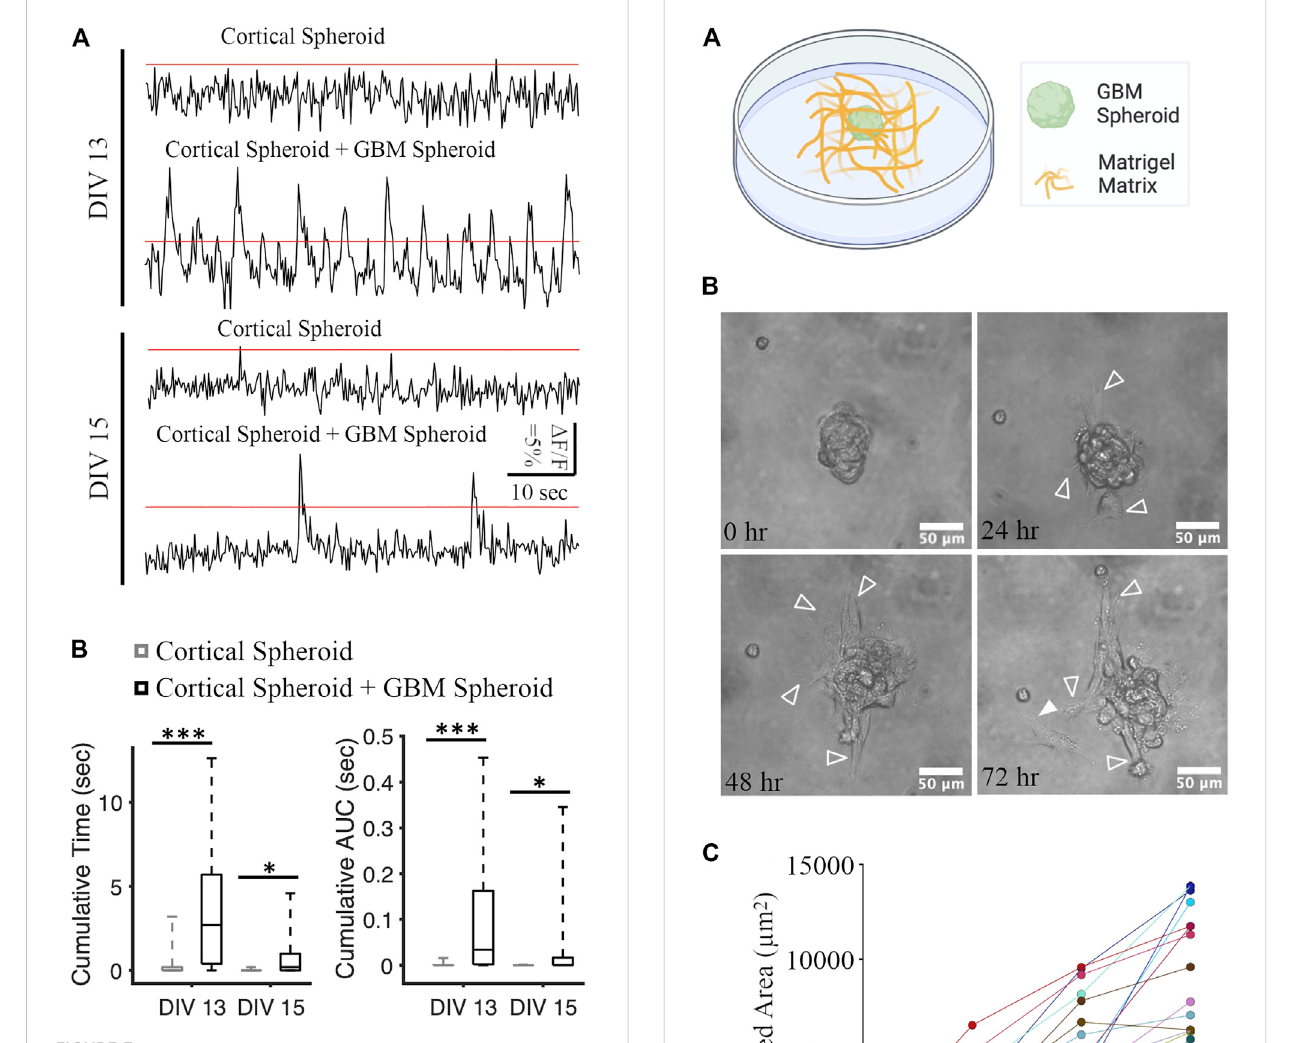
FIGURE 3 Analysisofspontaneousneuronalactivityincorticalandcortical- GBM spheroids. (A) Representative traces of jRGECO1a (red fl uorescent genetically encoded calcium indicator) in cortical spheroid andcortical spheroid+ GBMspheroidinDIV13andDIV 15.Theredlinesrepresentthethresholdof5% Δ F/F.Scalebar:10 s,5% Δ F/F. (B) Boxplots of cumulative time and area under the curve (AUC) above threshold on different DIVs. N = 26 cortical spheroids and 24 cortical-GBM spheroids in DIV 13. N = 24 cortical spheroids and 22 cortical-GBM spheroids. KS test was used to measure statistical signi fi cance. * p < 0.05 and *** p < 10 – 5 .